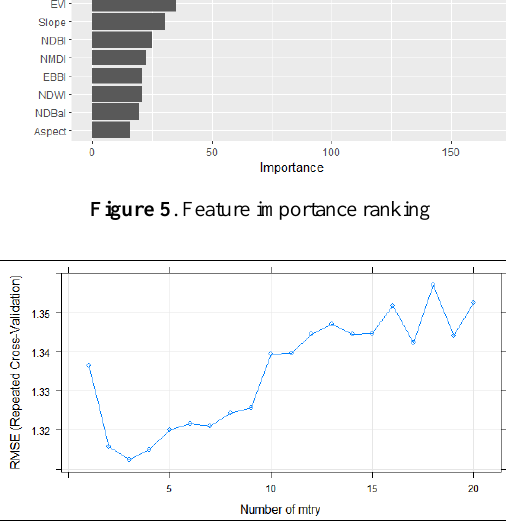
Figure 6 . Grid search for the number of variables at each split (mtry)